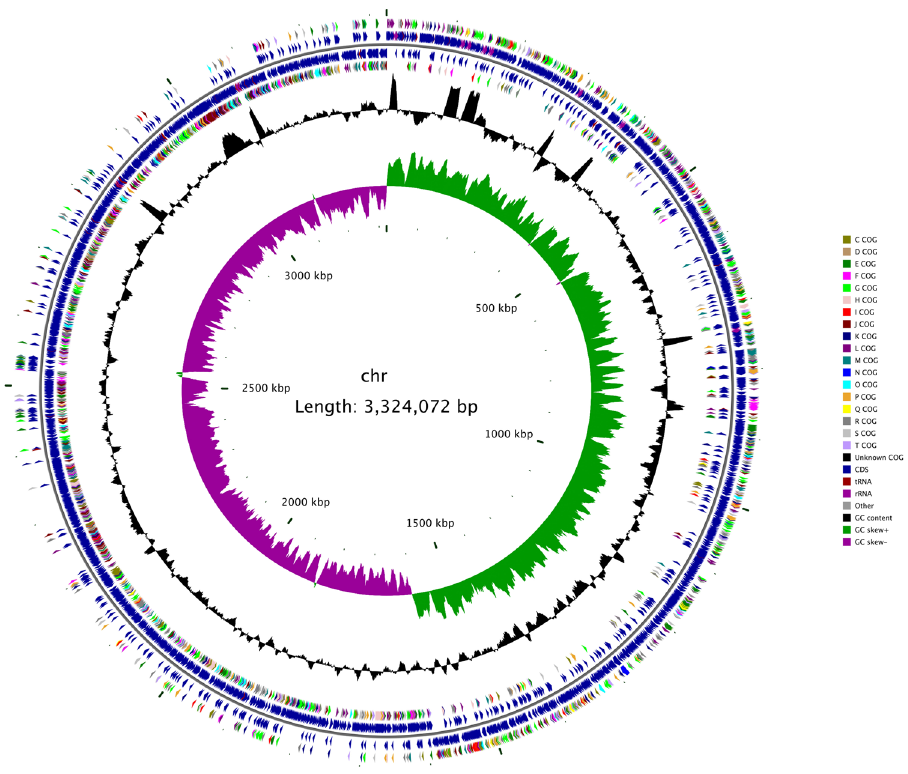
Figure 1. Circular map of the Clostridium perfringens JXJA17 strain chromosome. Summary of gene annotation and GC skew analysis of the genome of the JXJA17 strain. Circles (from inner to outer): circle 1 represents the scale; circle 2 shows the GC skew; circle 3 shows the GC content; circles 4 and 7 show the COG of each coding sequences (CDSs); and circles 5 and 6 show the positions of CDS. The genome atlas was drawn using CGView 1.0 (http://stoth ard.afns.ualbe rta.ca/cgvie w_serve